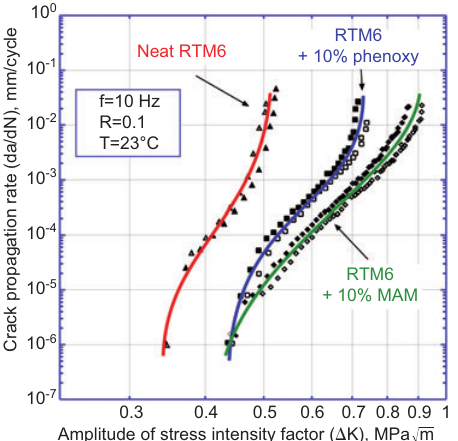
Figure 9 Crack propagation rate as a function of ∆ K.